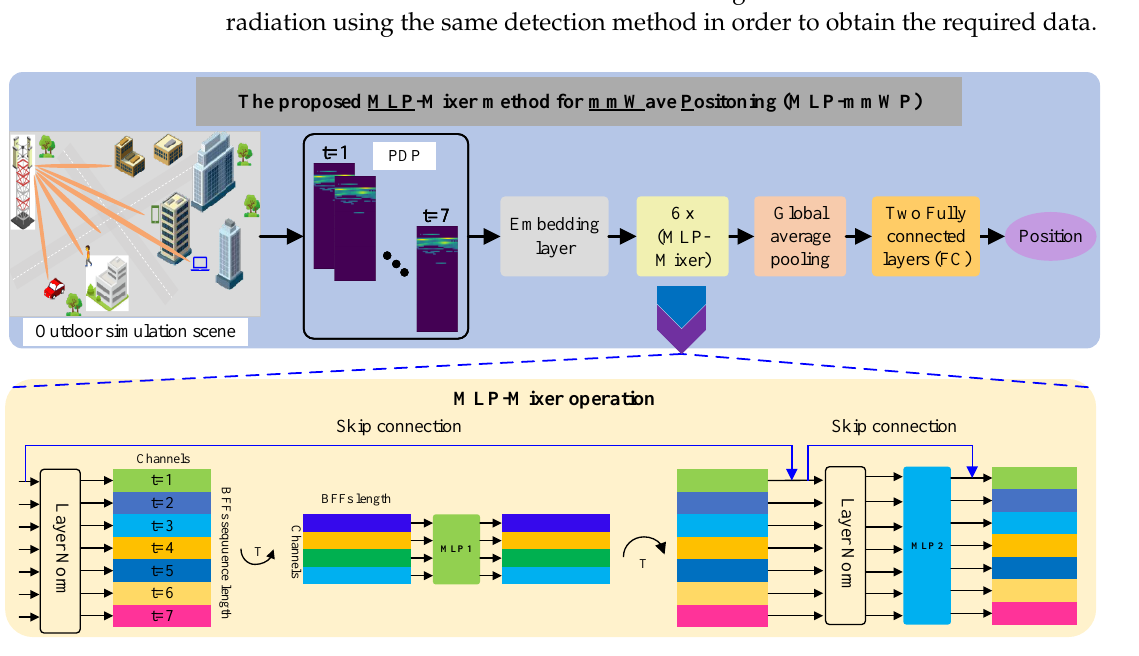
Figure 1. The pipeline of the MLP-mmWP method. The input data are the seven successive BFF data points (sampling in 7s), and the output is the predicted position ( x p , y p ). The yellow box at the bottom illustrates the detailed architecture of the MLP-Mixer